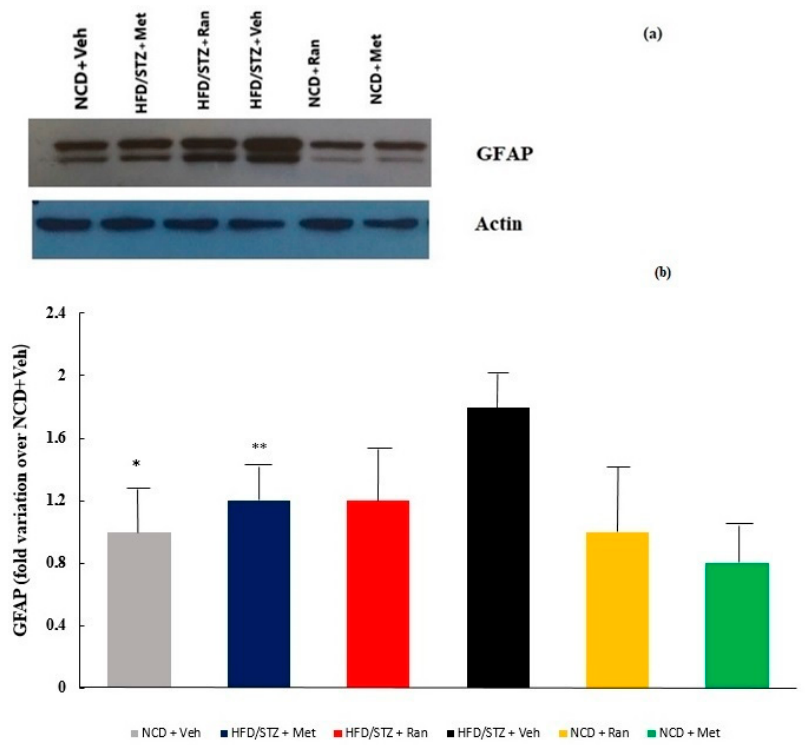
Figure 3. ( a ) Representative western blot images of glial fibrillary acidic protein (GFAP) (upper panel) and β -actin (lower panel). ( b ) Graph of GFAP variation in each experimental group. Data values are the mean ± SE (standard error) after normalization for β -actin, and expressed as fold variation over NCD + Vehicle group. ( n = 3–4 per group). HFD = high fat diet; NCD = normocaloric diet; STZ = streptozotocin; Ran = ranolazine; Met = metformin; GFAP= glial fibrillary acidic protein. * p = 0.046 NCD + Vehicle vs. HFD/STZ + Vehicle, ** p = 0.04 HFD/STZ + Metformin vs. HFD/STZ + Vehicle.